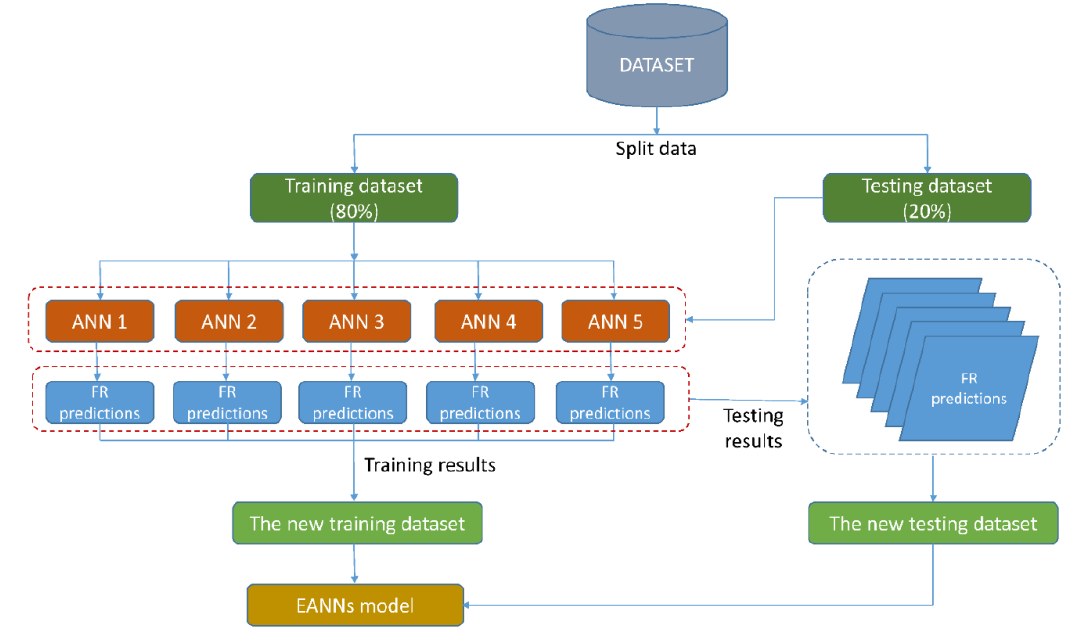
Figure 5. Context of the ANNs ensemble for estimating fly-rock distance (FR) in this work.